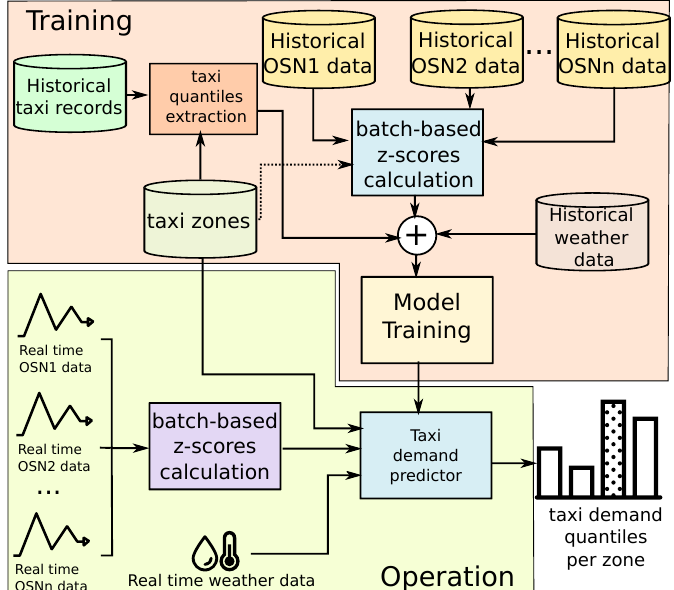
Figure 3. Architecture of QUADRIVEN. In the training stage, historical data from n different OSNs are used. From these data, the z-scores associated with the number of active users per taxi zone are calculated following a batch processing. Those scores along with historical weather data are used to compose the independent variables of the training dataset. The dependent variable (label) is generated by extracting the quantile ranges of the taxi demand per taxi zone. Once the model has been trained, it takes the z-scores of the active users considering the last d days along with the current weather conditions to compose the qualitative taxi demand prediction per hour and taxi